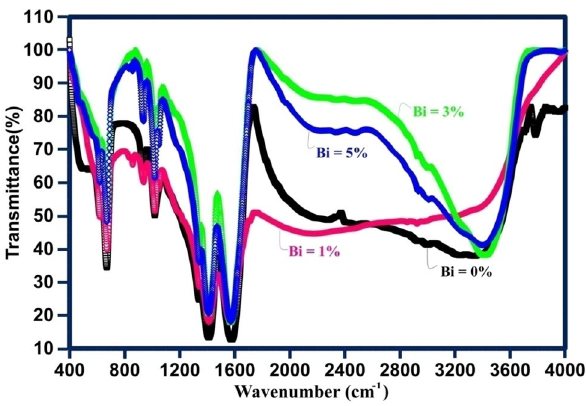
Fig. 7 PL spectra of Cd Bi 3+ concentrations (x = 0, 1, 3 and